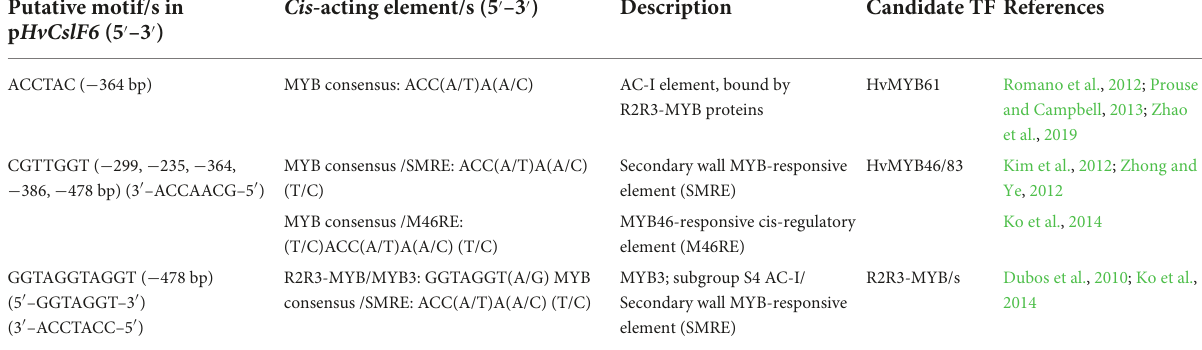
TABLE 1 Description of putative binding sites found in the HvCslF6 promoter based on dual luciferase results of deletion constructs with differential promoter activity. Cis -acting element/s (5 (cid:48) –3 (cid:48) ) Putative motif/s in p HvCslF6 (5 (cid:48) –3 (cid:48) )